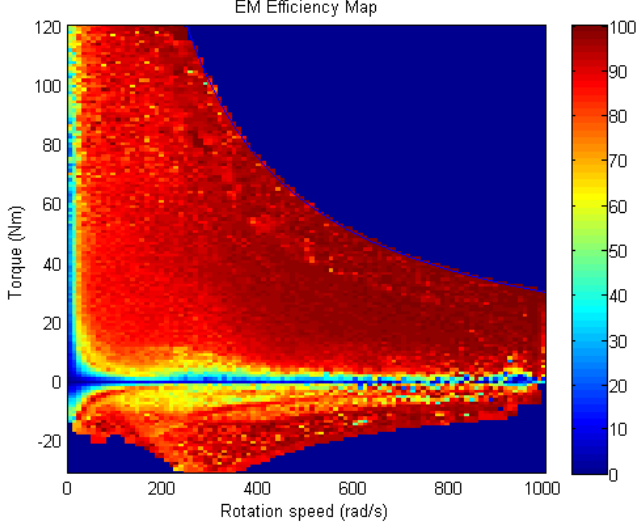
Figure 1. Efficiency map from Simulink electric machine (EM)